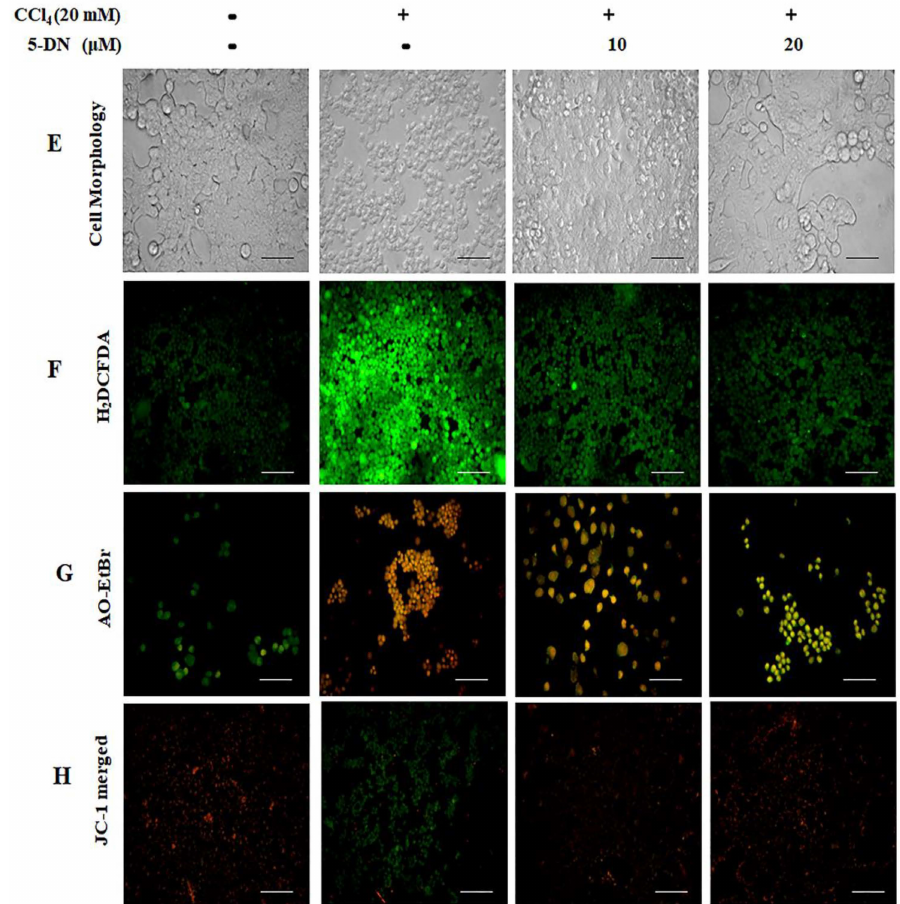
Figure 1. 5-O-Demethylnobiletin (5-DN) rescued HepG2 cells from carbon tetrachloride (CCl 4 )-induced cell death. ( A ) 3-(4,5-Dimethylthiazol-2-yl)-2,5-diphenyltetrazolium bromide (MTT) assay at different time points after varying doses of CCl 4 (5, 10, 20 mM). ( B ) MTT assay after 24 h treatment to HepG2 cells with different doses of 5-DN (10, 20, 40 µ M). ( C ) MTT assay after co-treatment with CCl 4 (20 mM) and 5-DN (10, 20, 40 µ M). ( D ) Estimation of LDH, malondialdehyde (MDA), and GSH from HepG2 cell homogenates. ( E ) Cell morphology of HepG2 cells after 24 h co-treatment with CCl 4 and 5-DN. ( F ) H 2 DCFDA staining of HepG2 cells. ( G ) AO-EtBr staining of HepG2 cells after 24 h co-treatment with CCl 4 and 5-DN. ( H ) JC-1 staining of HepG2 cells after 24 h co-treatment with CCl 4 and 5-DN. Magnification: 200 × , Scale bar (100 µ M). Images were captured using Olympus BX51 fluorescence microscope. The data represented here are the mean ± S.D. from three independent experiments where * p < 0.05, ** p < 0.01, *** p < 0.001, Control vs CCl4, CCl 4 vs. 5–DN (1–2 mg/kg). Statistical significance analysis was carried out through one-way analysis of variance (ANOVA)